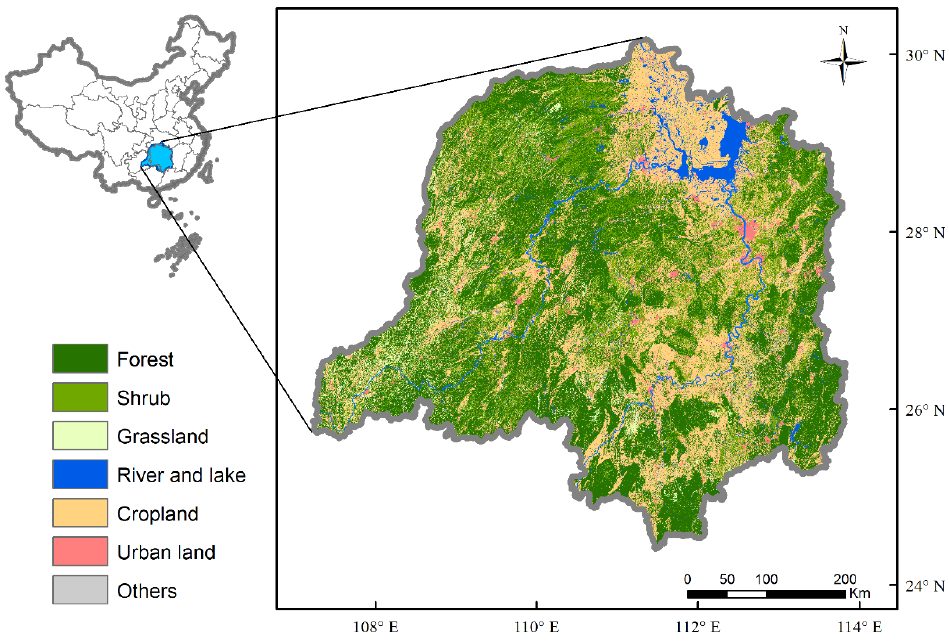
Figure 1. Study area.